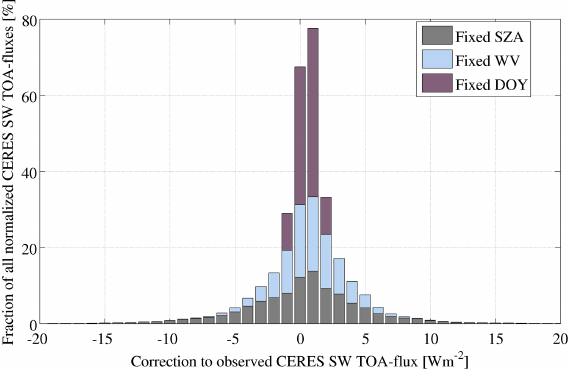
Figure 7. Distribution of the absolute corrections made to the ob- served CERES fluxes due to the normalization to fixed solar zenith angle, atmospheric water vapor content and day of year. The distri- bution includes all CERES observations within the study area be- tween March and October 2009 that have been used in the